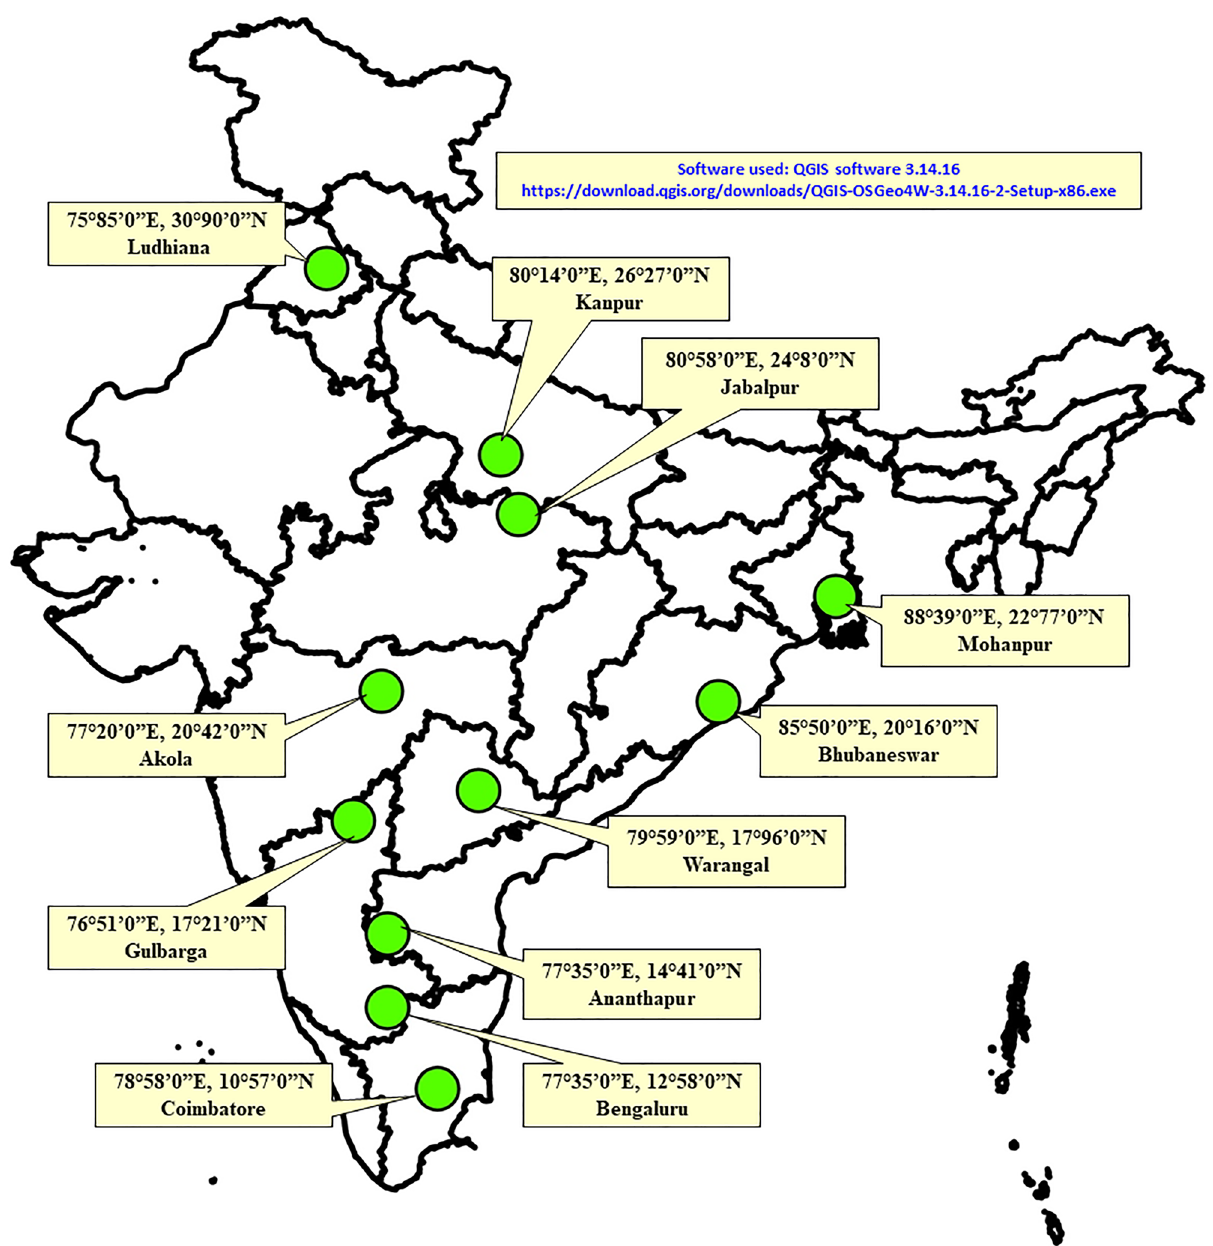
Figure 1. Selected pigeonpea locations of India for the study in India map using QGIS software version 3.14.16. The URL is https:// downl oad. qgis. org/ downl oads/ QGIS- OSGeo 4W-3. 14. 16-2- Setup- x86.